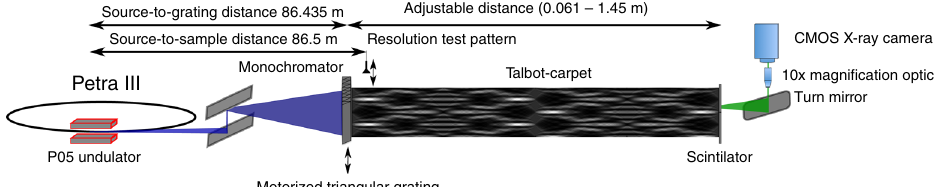
Fig. 2 Schematic of the experimental set-up used. X-rays emerging from an undulator are monochromatized and propagating to the triangularly shaped grating, which can be moved in the horizontal direction with a piezo-electric actuator. At a distance of 65 mm downstream the grating, the specimen (resolution test chart) is placed on a sample positioning stage. Another 5 mm away, the detector is placed. For the Talbot-carpet measurement, the grating to detector distance fi rst is slightly reduced and then the detector is moved in steps of 1 mm away from the grating, up to a maximum grating to detector distance of 1.43